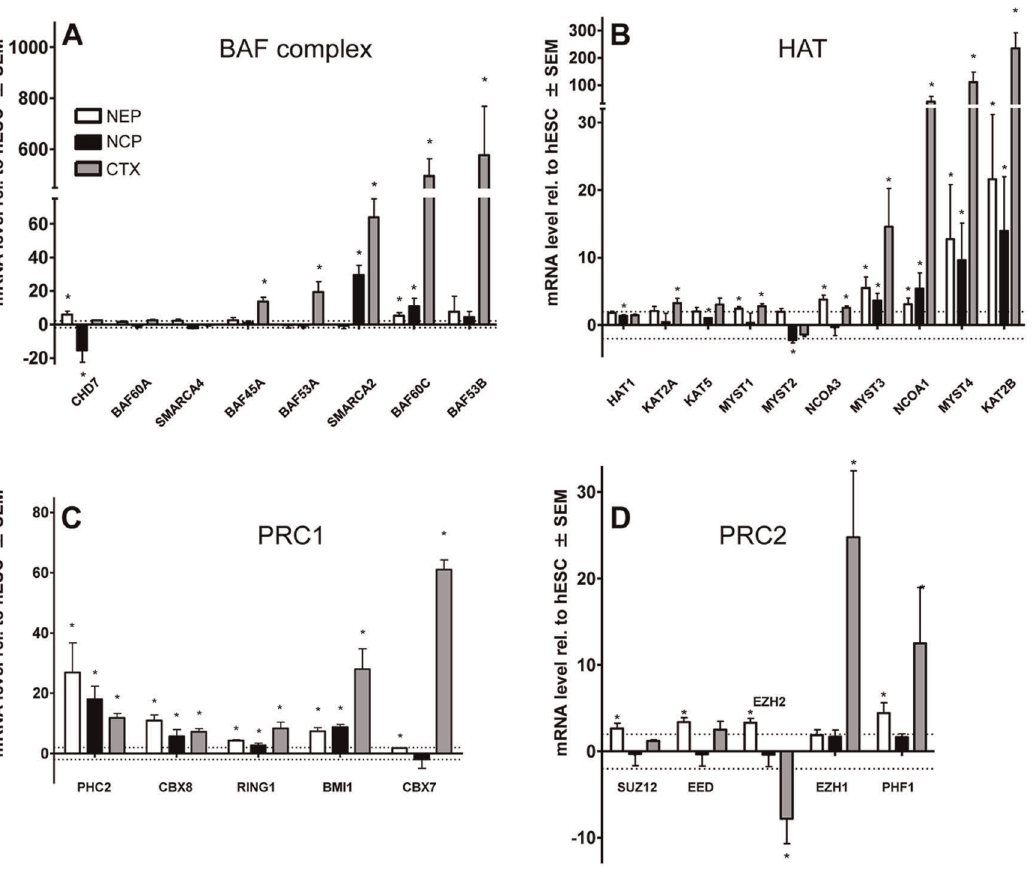
Figure 7. Synopsis of the regulation of different epigenetic modifier groups at different stages of neuronal differentiation. Four groups of epigenetic modifiers were selected for a comparison of relative expression levels of NEP, NCP and CTX. Data were obtained, and significances calculated as described earlier. All data are means 6 SEM of three independent differentiations. (A) Genes that code for subunits of the BAF remodeling complex. (B) Genes that code for histone acetyl transferases (HAT). (C, D) Genes that are involved in PRC1 and PRC2 complex formation. *: p , 0.05 vs hESC transcript level.